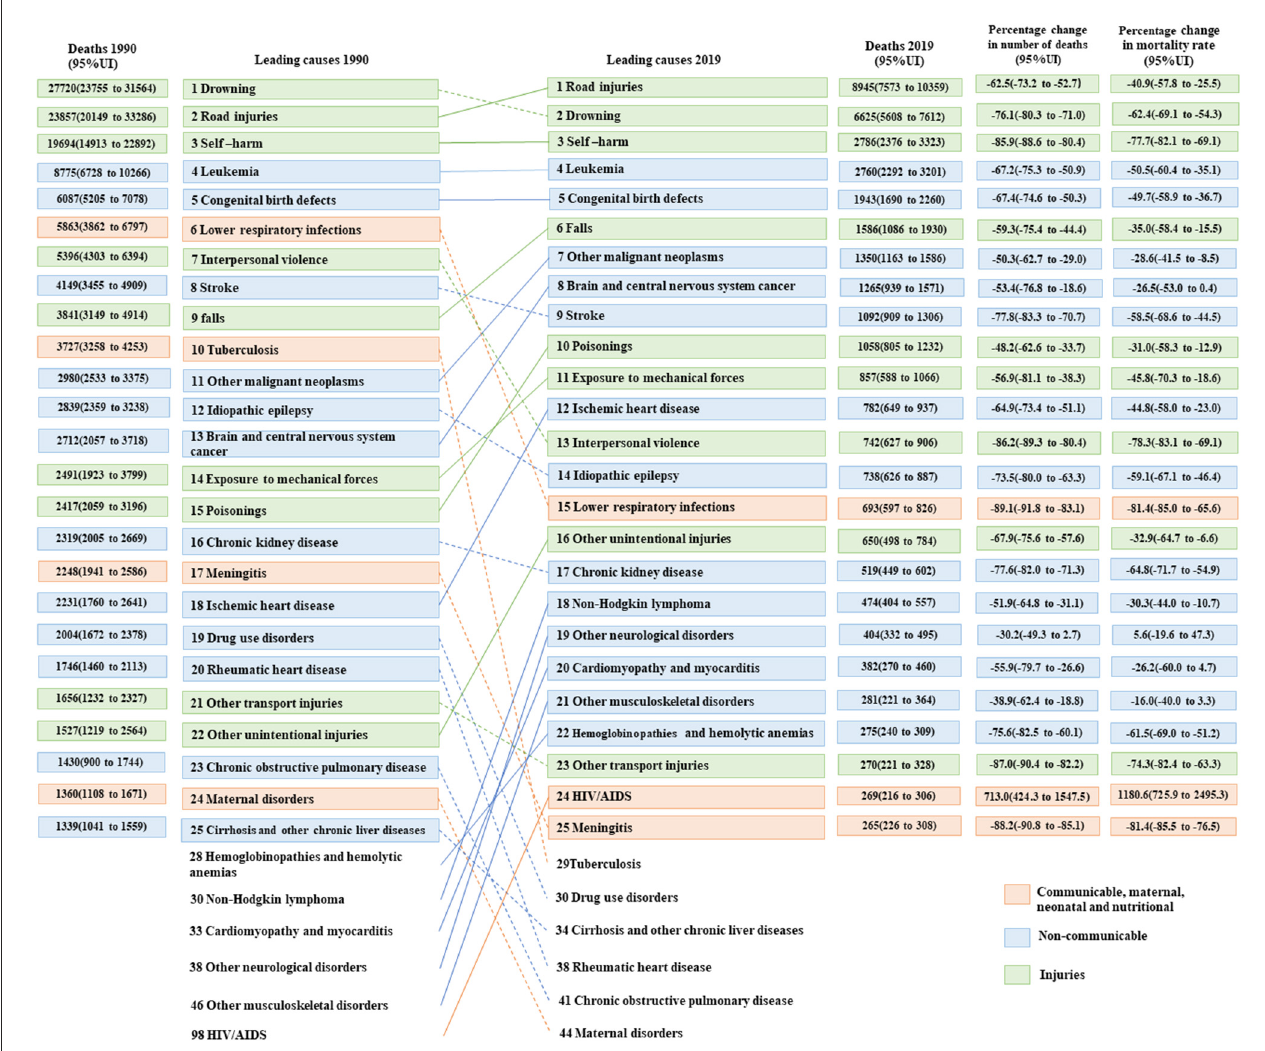
FIGURE3 Top 25 causes of death in China, aged 10–19 years, both sexes, 1990 and 2019.